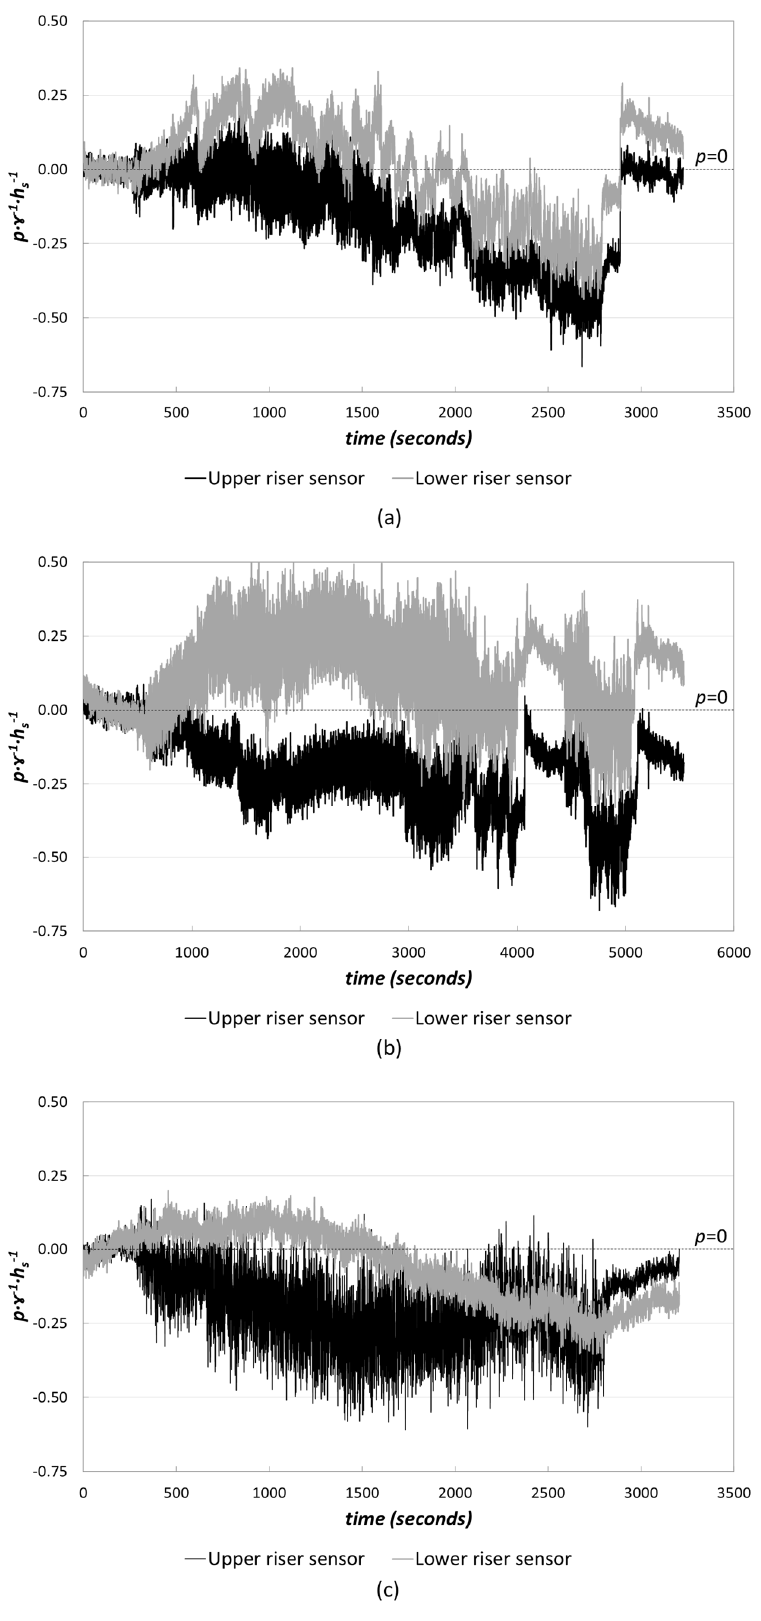
Figure 17. Hydrodynamic pressures on the Armorwedge TM block (w1) riser in rows: ( a ) 15; ( b ) 25; ( c ) 35 for unit flow rates (q). They range from 0.04 m 2 s − 1 to 0.24 m 2 s − 1 and a decrease to zero dis- charge.